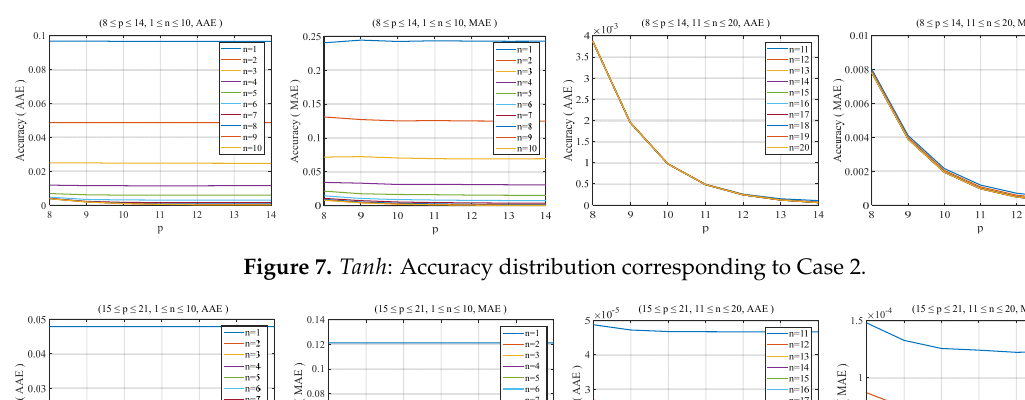
Figure 6. Sigmoid : Accuracy distribution corresponding to Case 2.